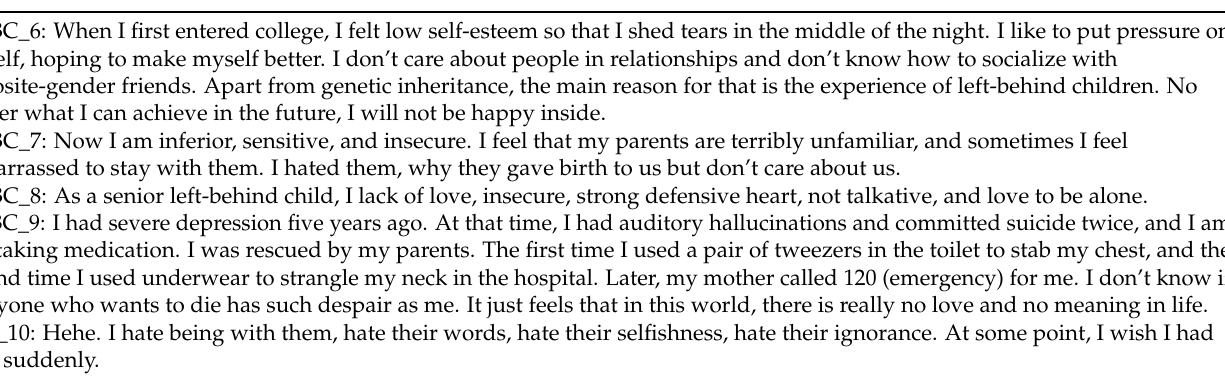
Table 8. Five representative personal narrative texts of LBC related to depression and